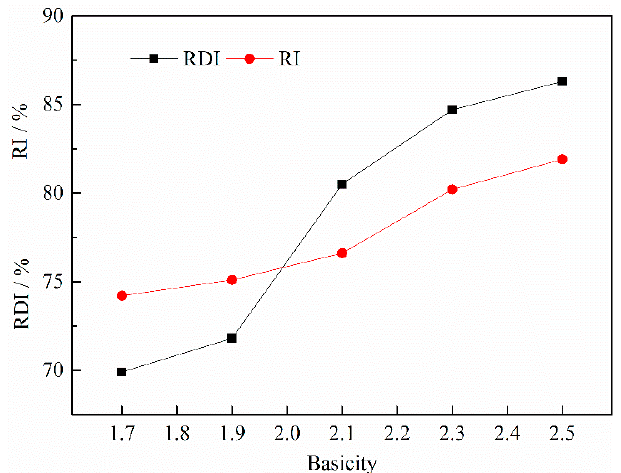
Figure 7. Reduction disintegration index (RDI) and reducibility index (RI) of HCVTM sinters with different basicity.